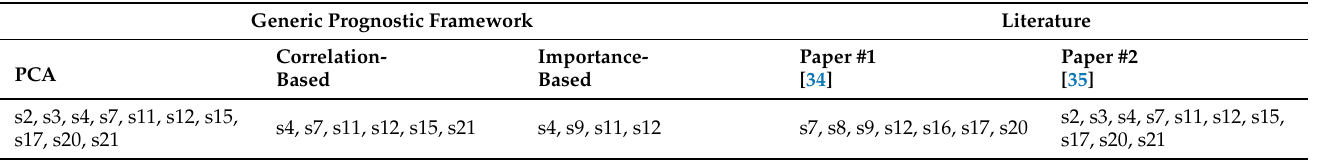
Table 5. The selected most relevant features of the C-MAPSS FD001 dataset by the methodologies included in the GPF and in existing